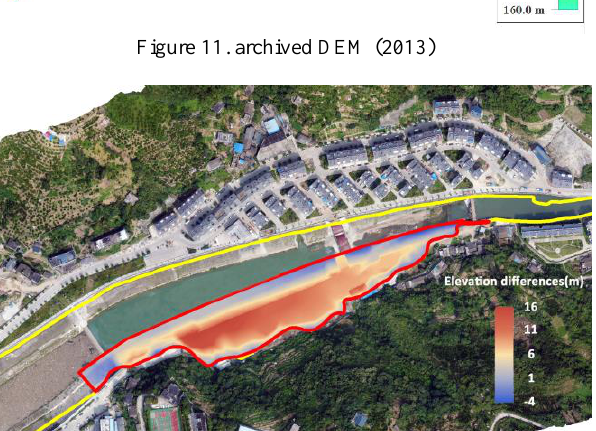
Figure 12. Increase in elevation of by comparison of archived DEM and the current